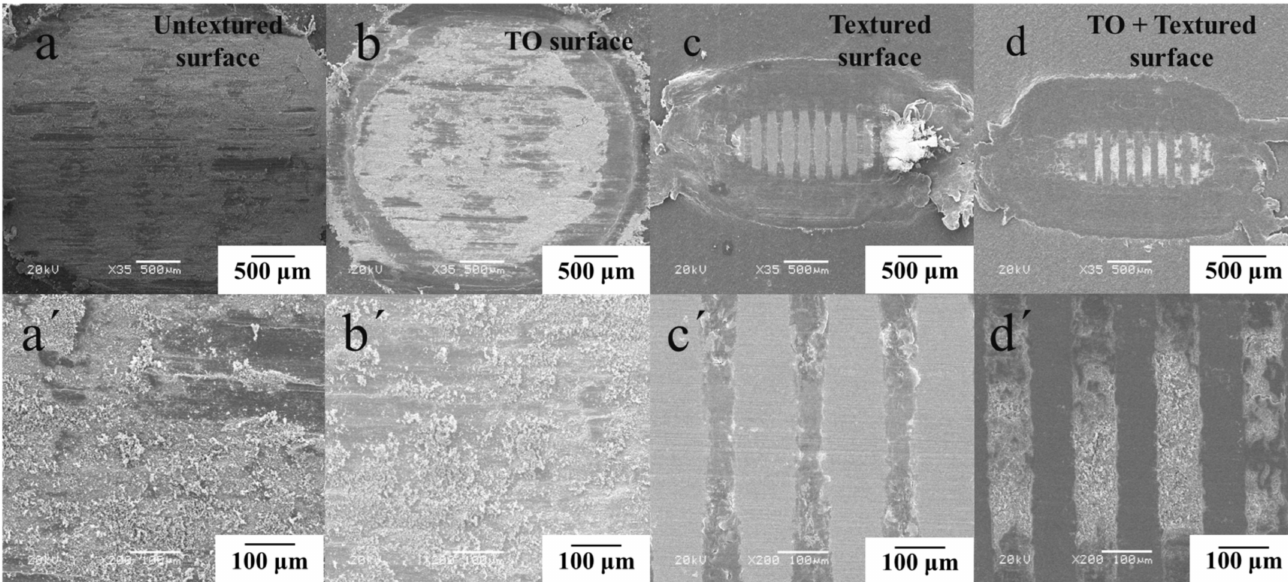
Figure 9. SEM micrographs of the worn surfaces of different surface structures ( a – d ) and correspond- ing local worn surfaces ( a’ – d’